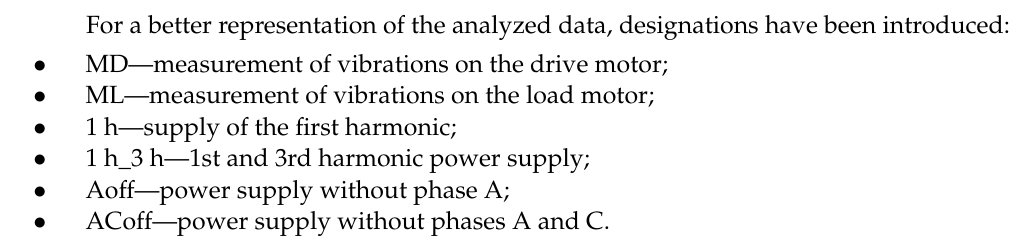
Figure 7. Vibration rms distribution characteristics for an unloaded motor and a rotational speed of 150 rpm.